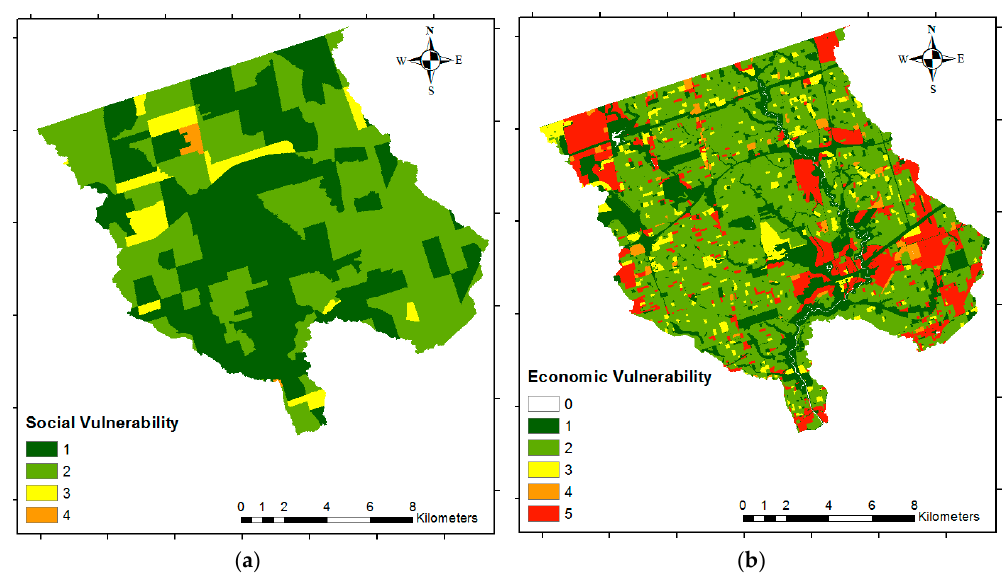
Figure 7. Vulnerability maps; ( a ) social vulnerability; ( b ) economic vulnerability.